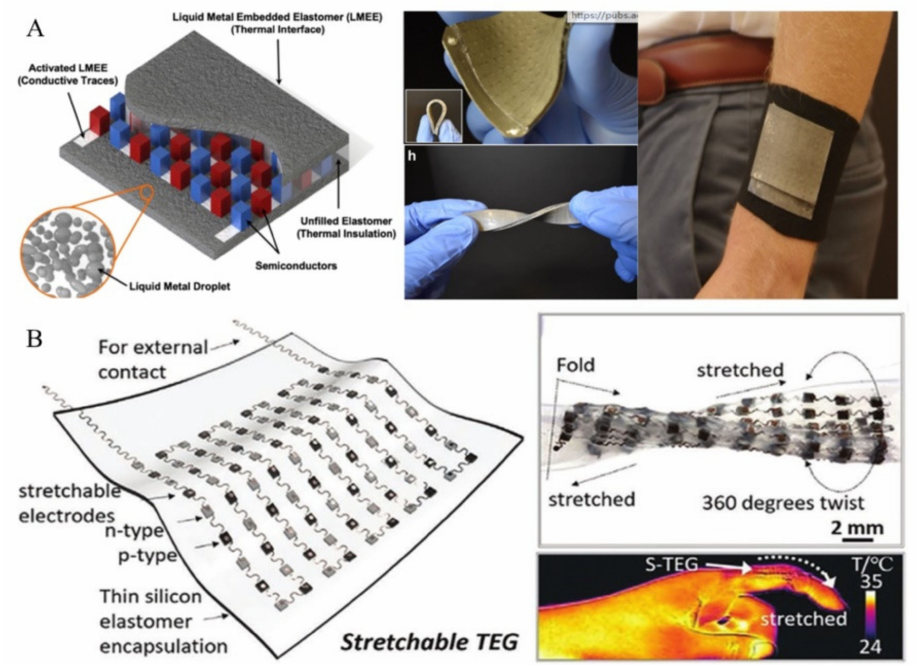
Figure 6. ( A ) s-FTEGs with stretchable liquid metal electrodes [52]. ( B ) s-WTEGs with snake-shaped copper electrodes